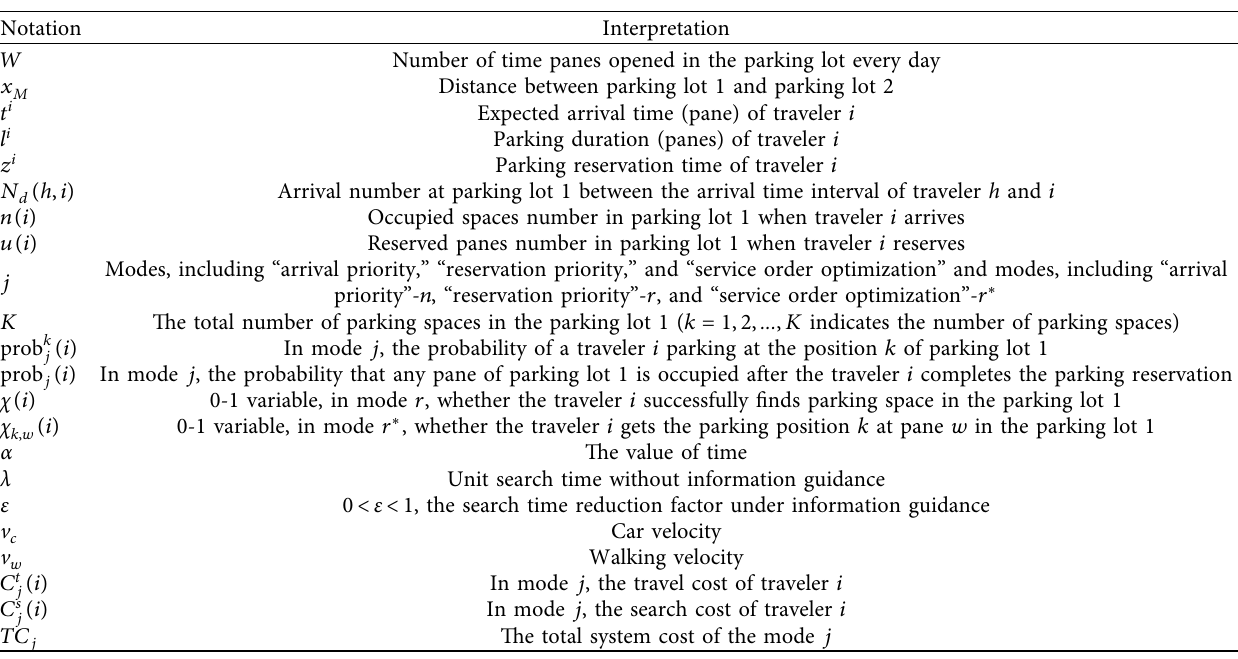
Figure 2: The parking process of travelers in mode n . Table 1: